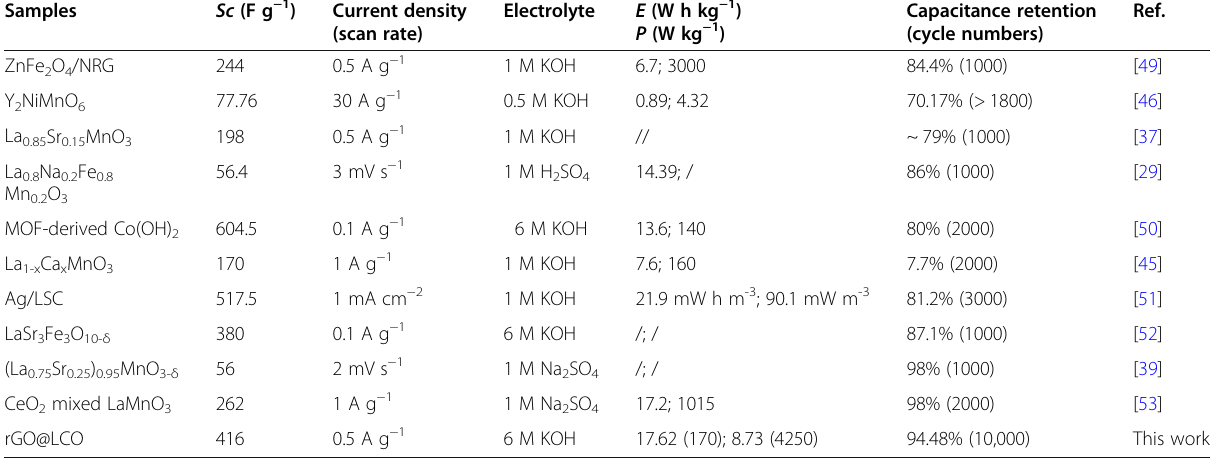
Table 2 Comparison of electrochemical performances for some composite electrodes in the previous literatures